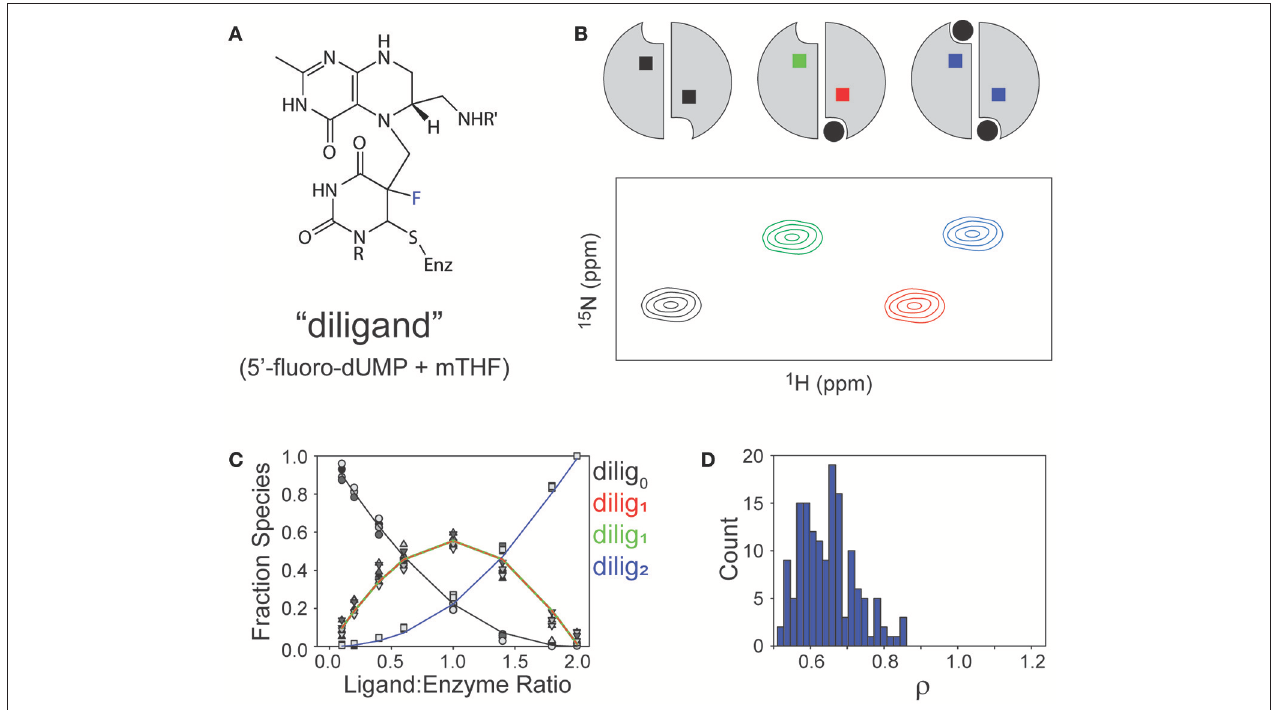
FIGURE 4 | Observations of binding “diligand” to ecTS. (A) Chemical structure of stable “diligand” as a model for intermediate II in the reaction mechanism (see Figure 1 ). The fluorine (blue) is a poor leaving group, which stabilizes this intermediate. (B) Schematic of the three liganded states of the TS homodimer (apo, lig 1 , lig 2 ) and a resultant “peak quartet.” Peaks are color coded to correspond with the liganded state (black = apo, blue = saturated) and to discriminate bound (red) and empty (green) subunits of the lig 1 state. (C) Fitting of relative K d values from quartet peak intensities, as reported in Sapienza et al. (ref 29). (D) Range of ρ values from monte carlo simulations of fit in (C)